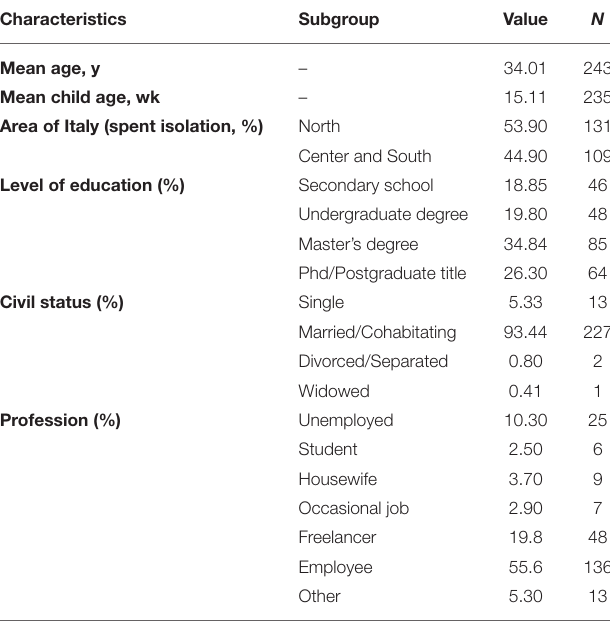
TABLE 1 | Sociodemographic characteristics of the